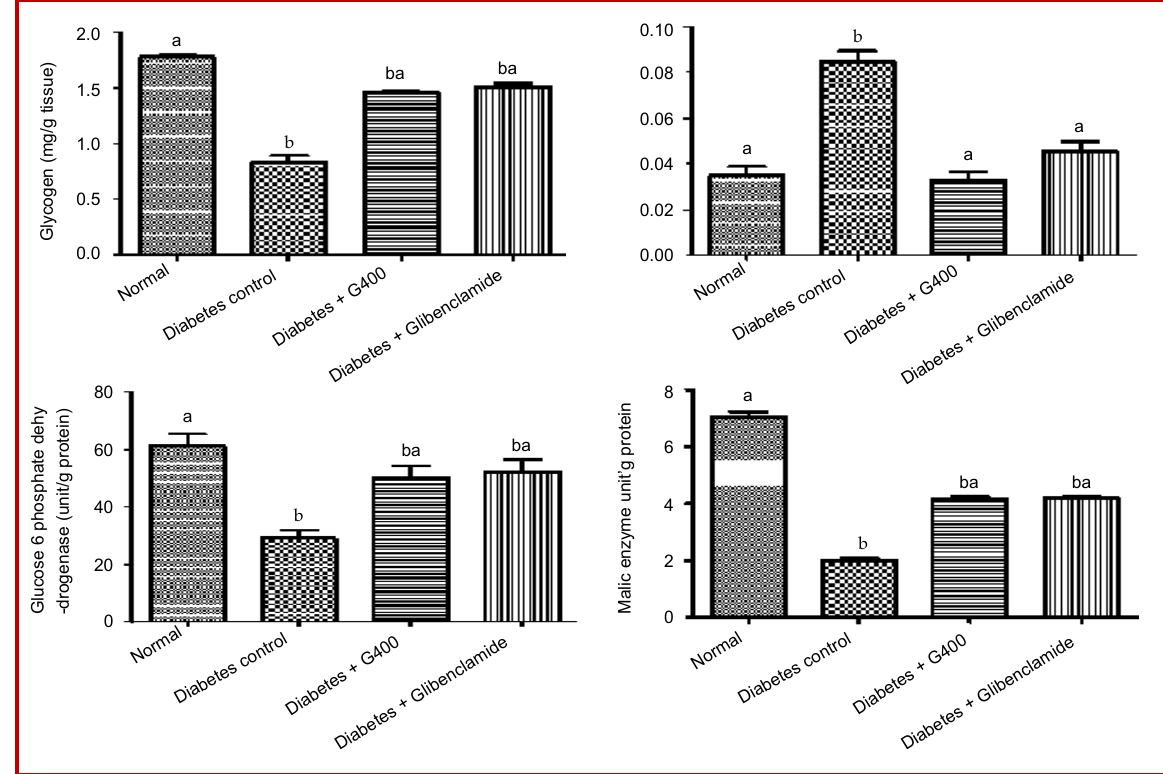
Figure 5: Effect of G-400 on glycogen level and the activities of glucose-6-phosphatase, glucose-6-phosphate dehydrogenase and malic enzyme in hepatic tissue Streptozotocin-treated diabetic rats were treated with G-400 (100 mg/kg) daily using an intragastric tube for 4 weeks. The results were compared with diabetic control rats (Group 2) and normal control (Group 1), where no streptozotocin was administered. The positive control in the study com- prises of rats administered with glibenclamide (0.025 mg/kg b.wt.) daily using an intragastric tube for 4 weeks. Results are expressed as mean ± SD of n = 4-6 independent assays. b p<0.05, statistically different from the control group, a p<0.05, statistically different from diabetic